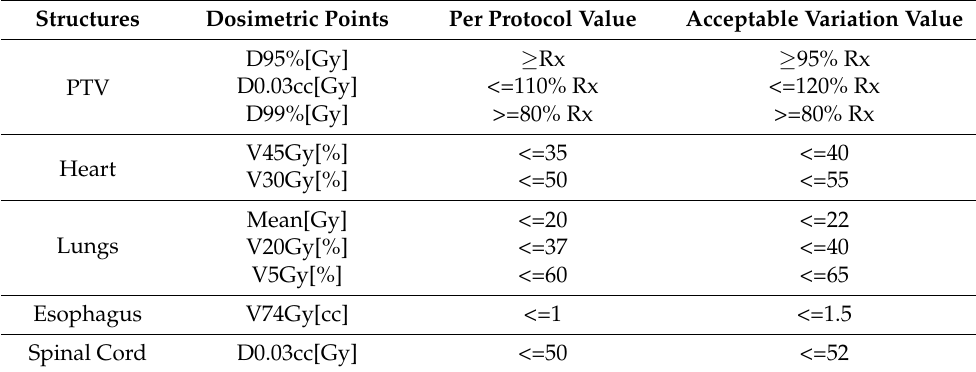
Table 1. QA dosimetric criteria for the RTOG 1308